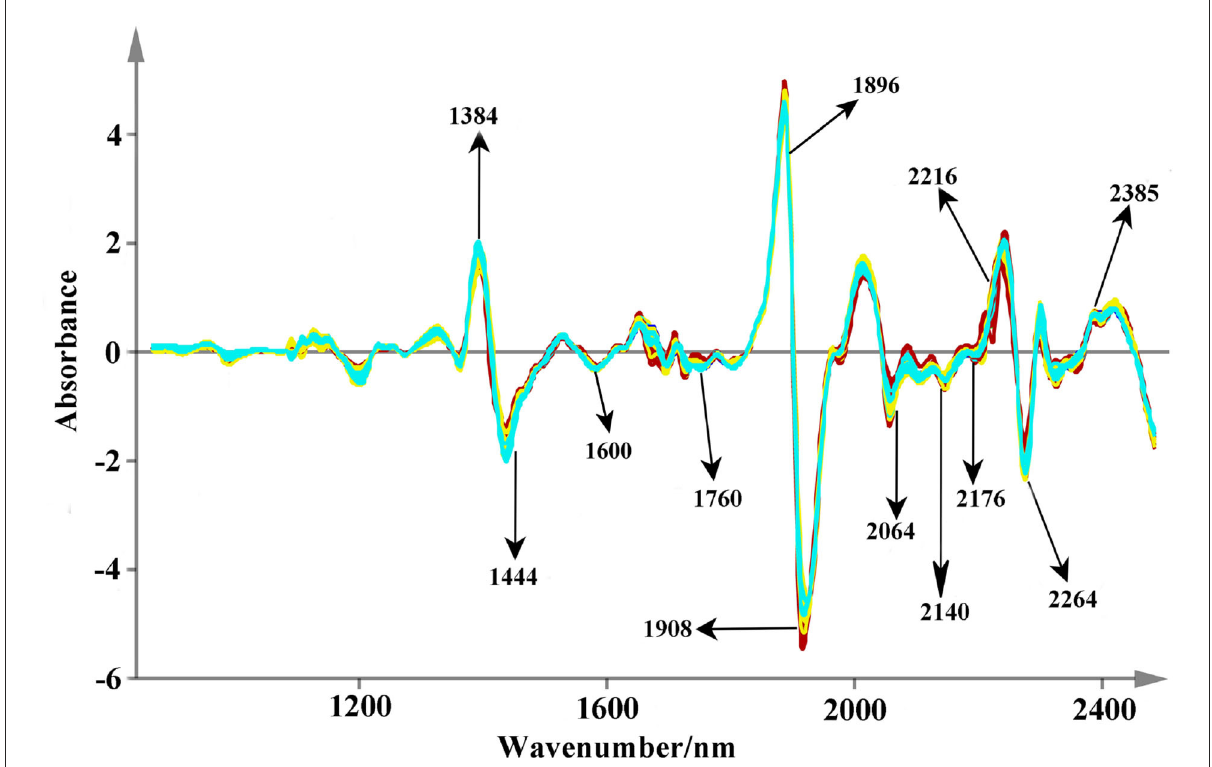
FIGURE5 The spectra fingerprints after the pretreatments (Description: Appropriate pretreatments can improve the quality of raw spectra. In this study, the smoothing, SNV, and 2D algorithm are applied simultaneously and some valuable peaks are also marked.).